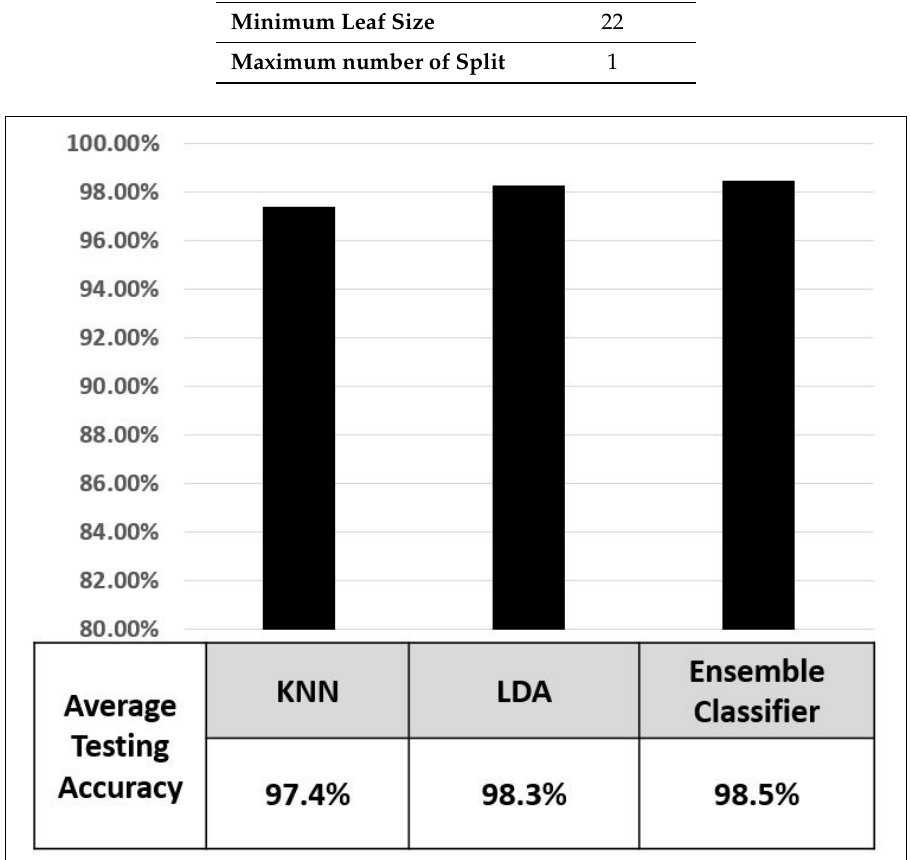
Figure 5. Average Testing